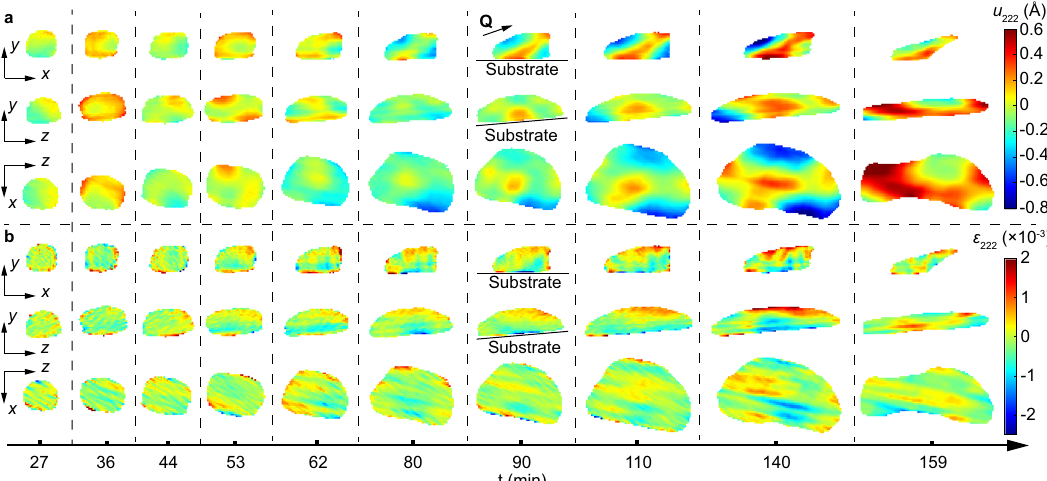
Fig. 3 Strain evolution in the IZrO grain. Orthogonal cuts through the 3D displacement ( a ) and strain fi elds ( b ) obtained with BCDI reconstruction of the IZrO grain as a function of annealing time. The scattering vector Q is shown in a at 90 min. The lengths of coordinate axes correspond to the 100 nm